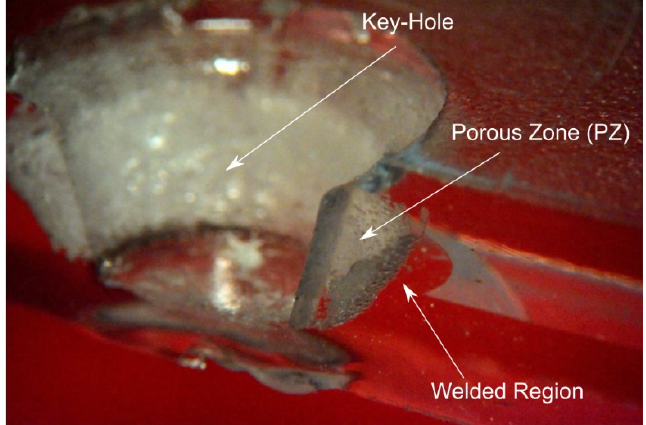
Figure 26. Characteristic interface areas of friction stir spot welds [74]: ( a ) stirred zone; ( b ) Aweld; ( c ) Aup and ( d ) Alow. Materials 2020 , 13 , x FOR PEER REVIEW